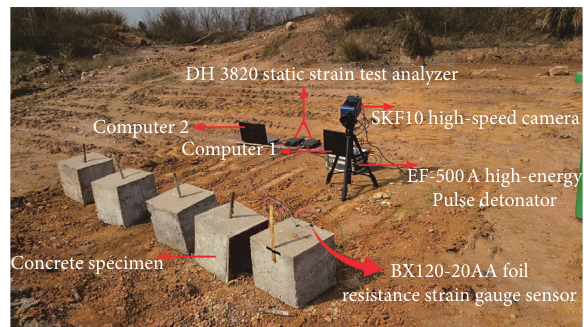
Figure 1: Experimental instrument layout in the